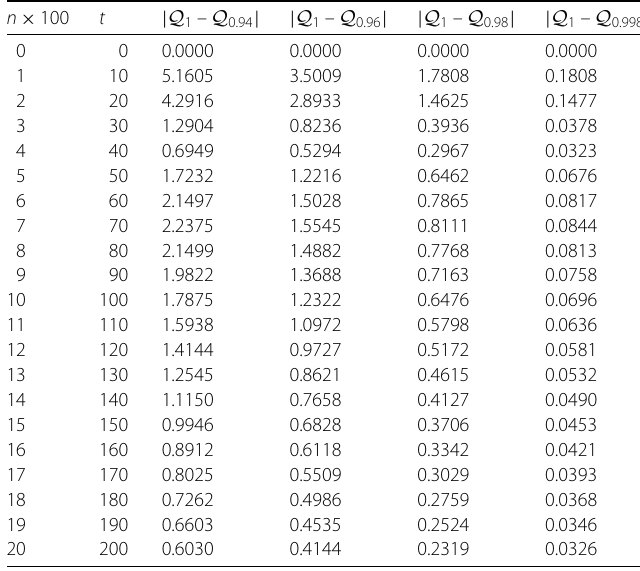
Table 11 The values of | Q 1 – Q φ | for φ = { 0.94,0.96,0.98,0.998